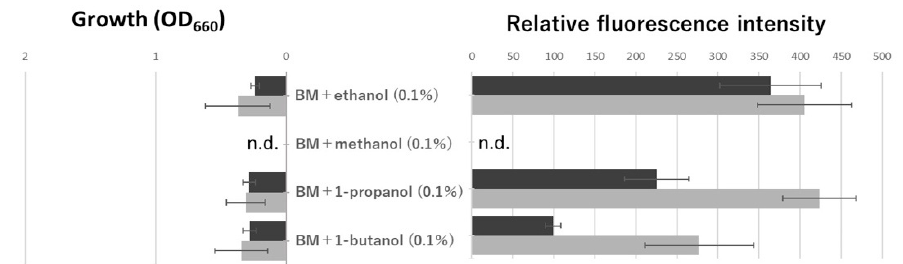
Figure 3. Oligotrophic gene expression in the medium containing various primary alcohols. The fluorescence intensity of the cells was measured as described in the legend in Figure 2. The cultivation time was 48 h.